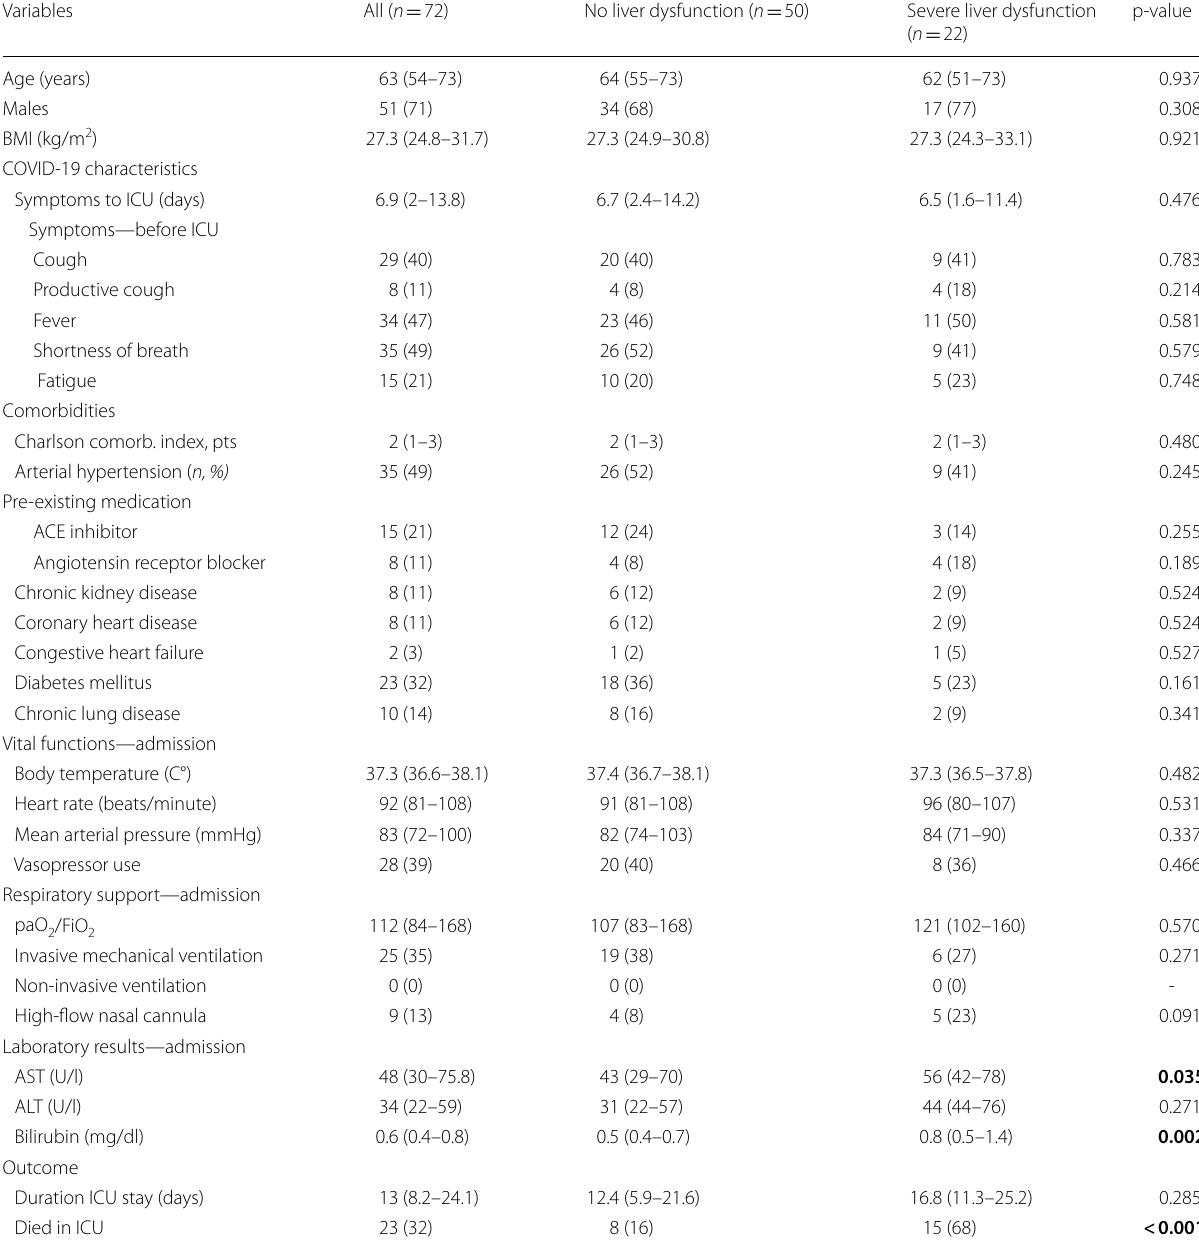
Table 1 Baseline characteristics of the study